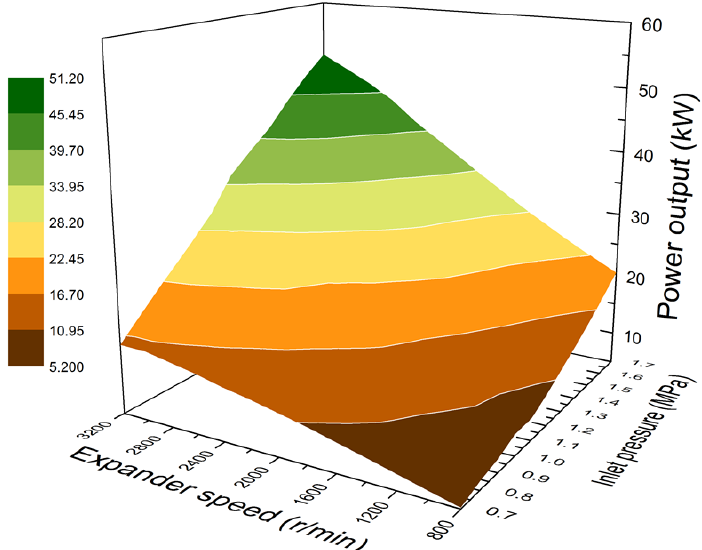
Figure 5. Variation of power output with inlet pressure and rotational speed.